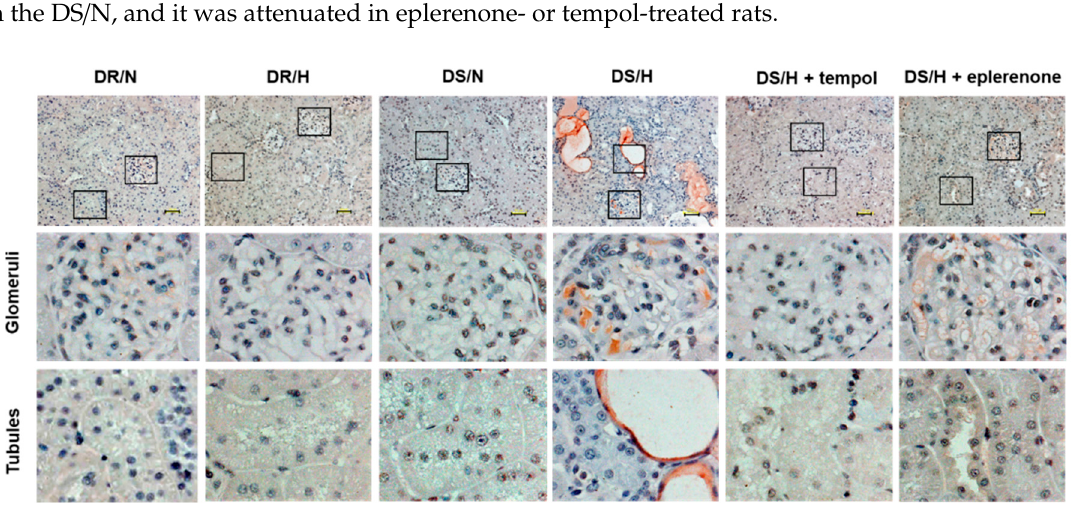
Figure 5. Immunohistochemical analysis of oxidative stress. Representative immunostaining of 4-hydroxy-2-nonenal (4-HNE) in the kidney of rats. Magnified views of glomeruli and tubules are from the indicated black boxes. 4-HNE was positive in the injured tubules of the rats. Scale bar, 50 μ m.